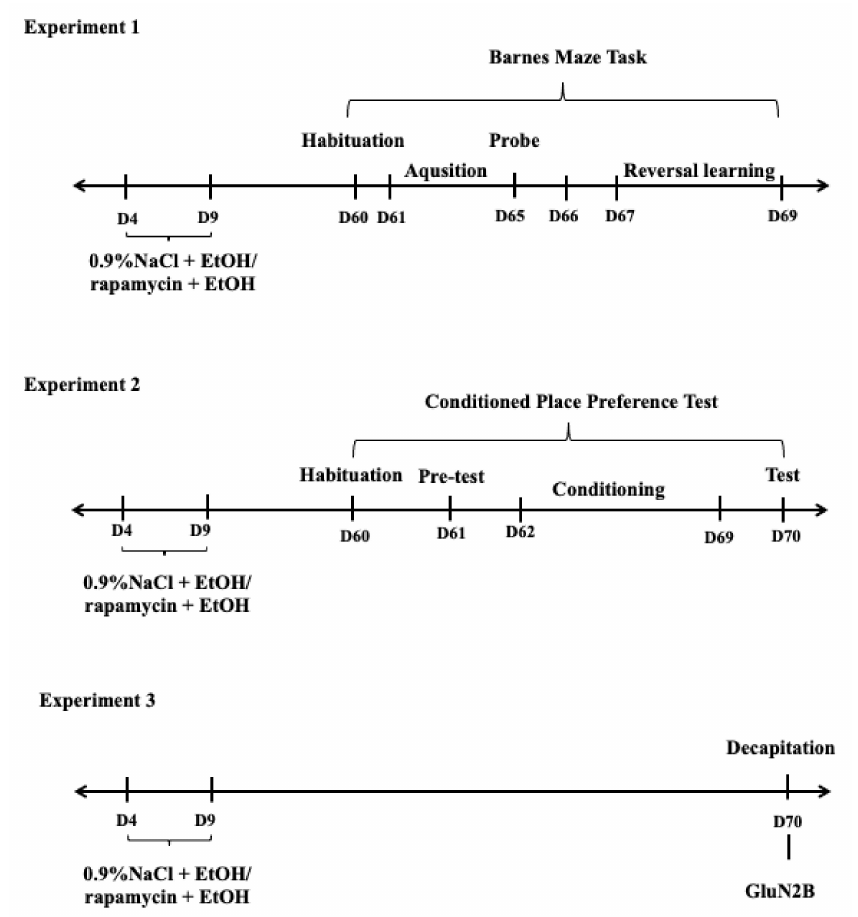
Figure 1. The diagram of experimental design. D-Days,